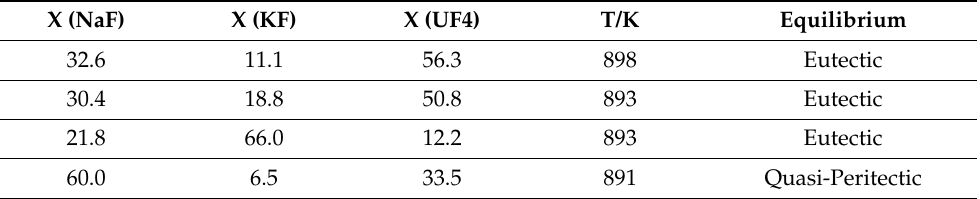
Table 8. Calculated invariant equilibria, temperatures, and compositions of the NaF-KF-UF 4